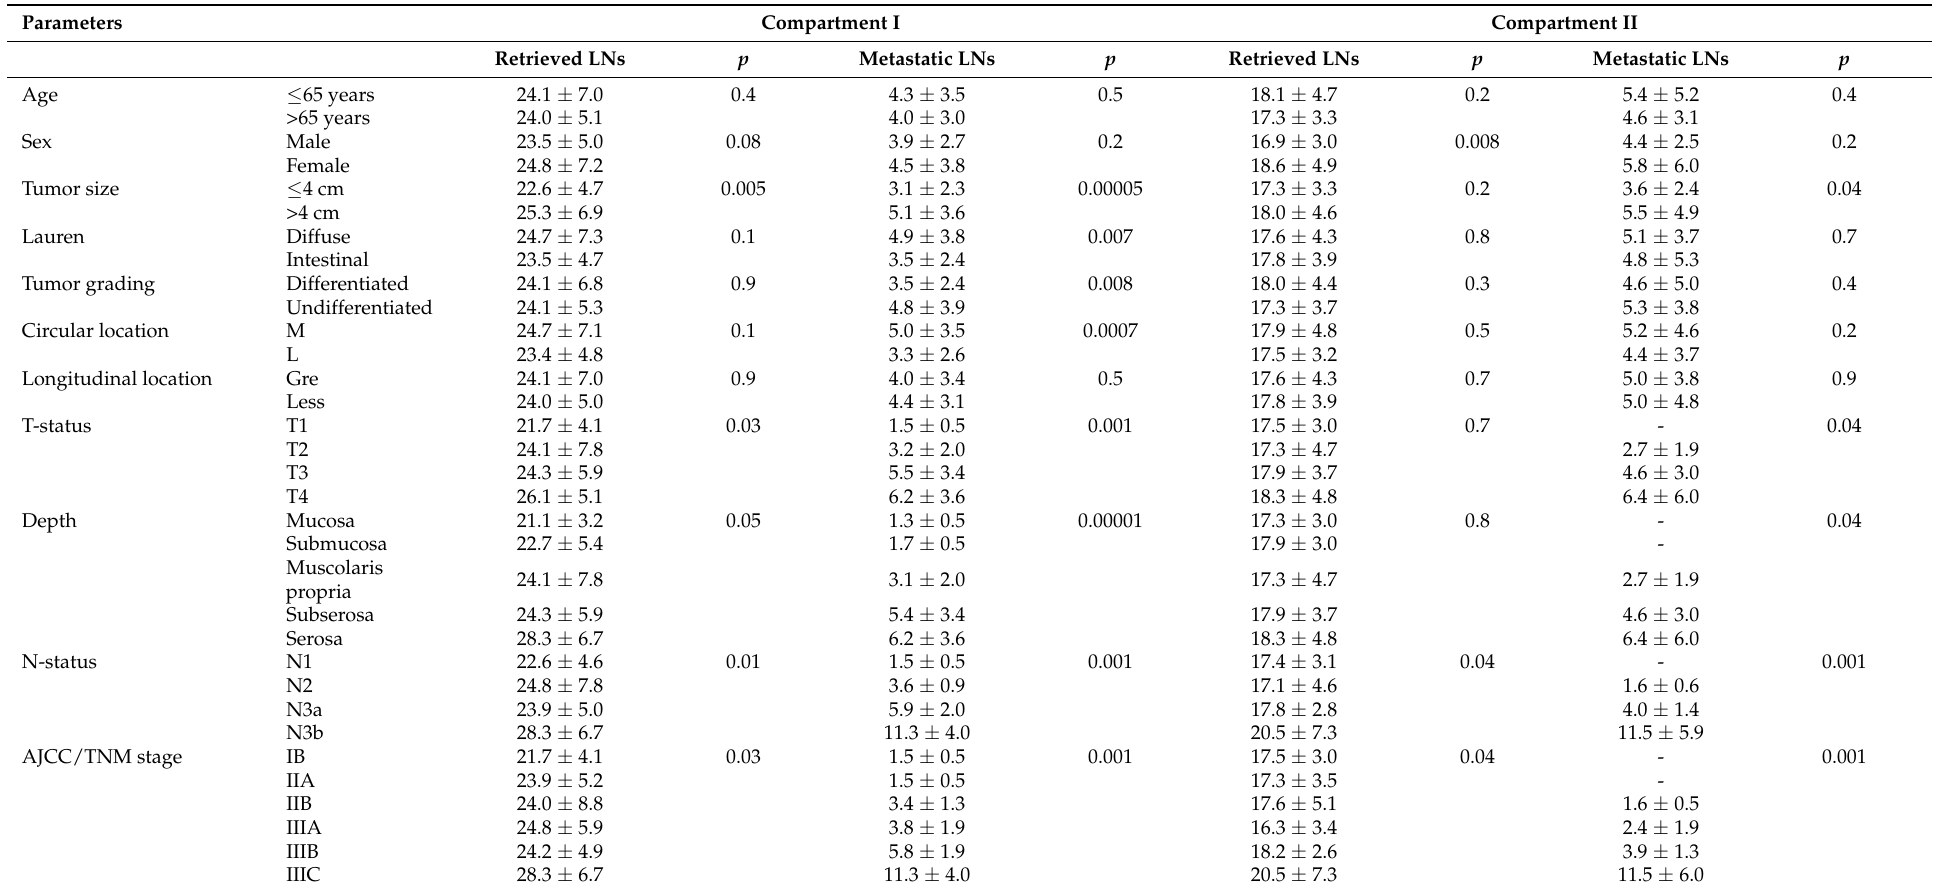
Table 4. Number of retrieved LNs and metastatic LNs in compartment I (stations 1 to 6) and compartment II (stations 7 to 12), in relation to in relation to the clinical, anatomical and pathological parameters considered.